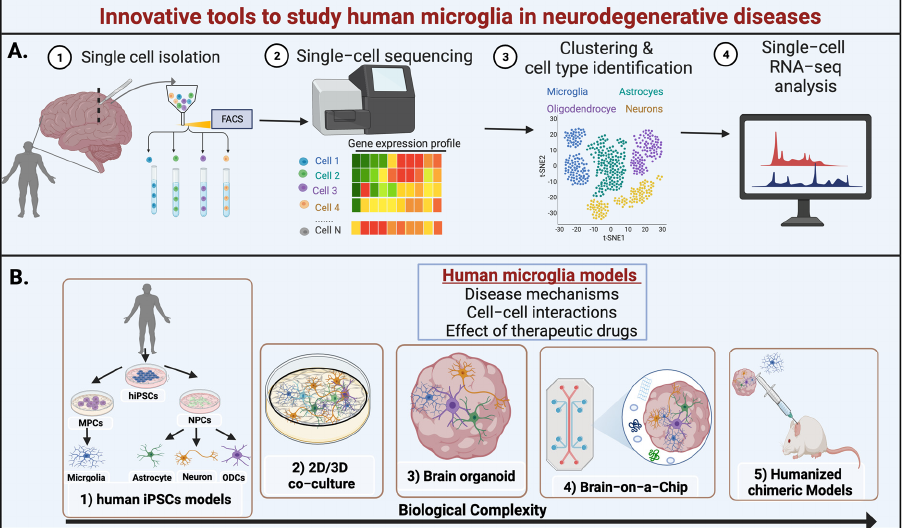
Figure 4. Innovative tools to study human microglia in neurodegenerative diseases. ( A ) Single-cell sequencing can be performed by isolating single cells from live or postmortem brains. This tool assists in characterizing the gene expression profiles of various cell types, which helps to understand the heterogeneous phenotypes of microglia in human diseases. ( B ) The generation of microglia-like cells from human-induced pluripotent stem cells (hiPSCs) has advanced mechanistic studies. iPSC can be derived from patients with neurodegenerative diseases or can be genetically modified to study human microglia responses in a specific disease environment. iPSC-derived microglia can also be co-cultured in two/three-dimensional systems or incorporated into brain organoids to study complex interactions of microglia with neurons and other cells. Brain-on-a-Chip technology employs a continuous flow of microscopic fluid in organoid systems, which enables the addition of extracellular matrix components to mimic the complex properties of the brain or incorporates pathogenic stimuli to emulate disease- specific brain microenvironment. Humanized microglia models, created through xenotransplantation of human iPSC-derived microglia models, help to study human microglia in intact models, and this technology is beneficial for translational research, such as therapeutic drug testing. Figure created using BioRender.com (accessed on 14 April